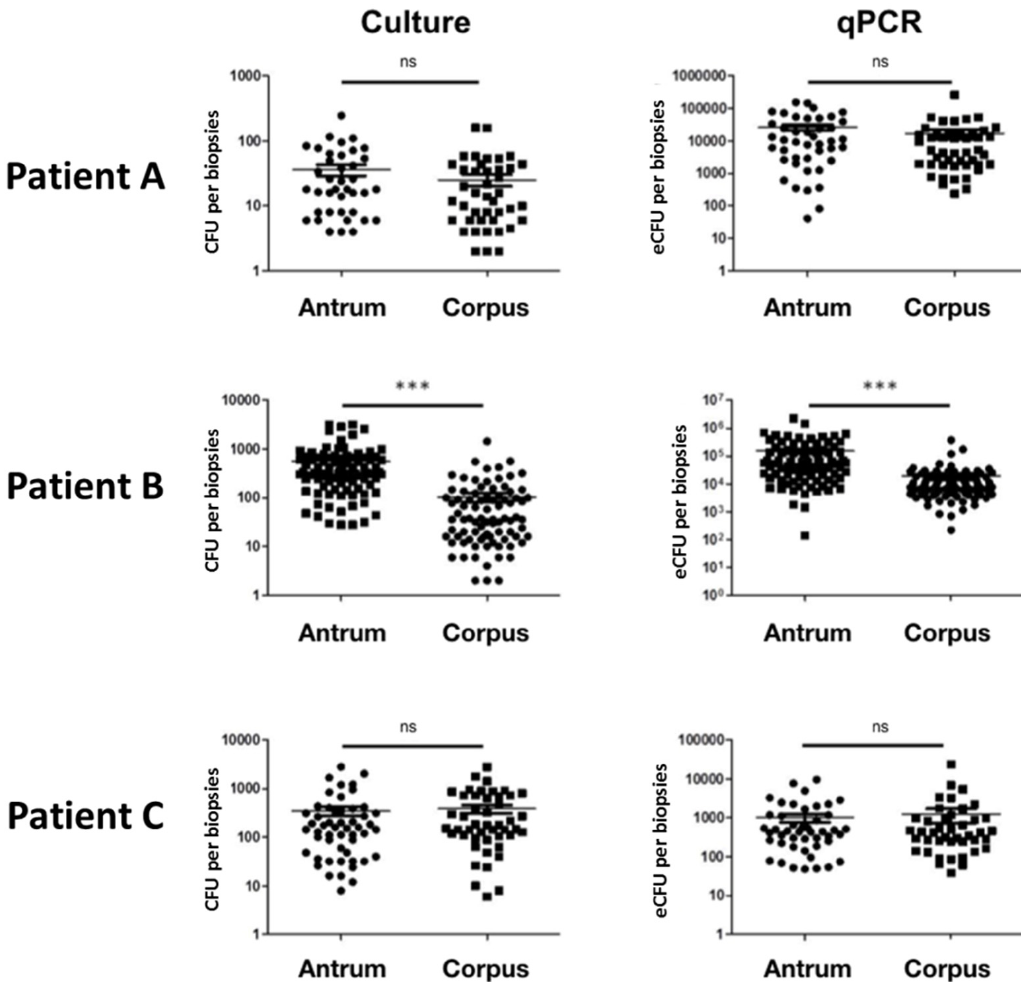
Figure 2. Bacterial load of H. pylori in biopsies depending on the quantification method and location. Ns, non-significant. *** p < 0.001. Significant difference between antrum and corpus was found by both culture and qPCR for patient B ( p < 0.001). No difference could be observed for patient A and B ( p = ns).